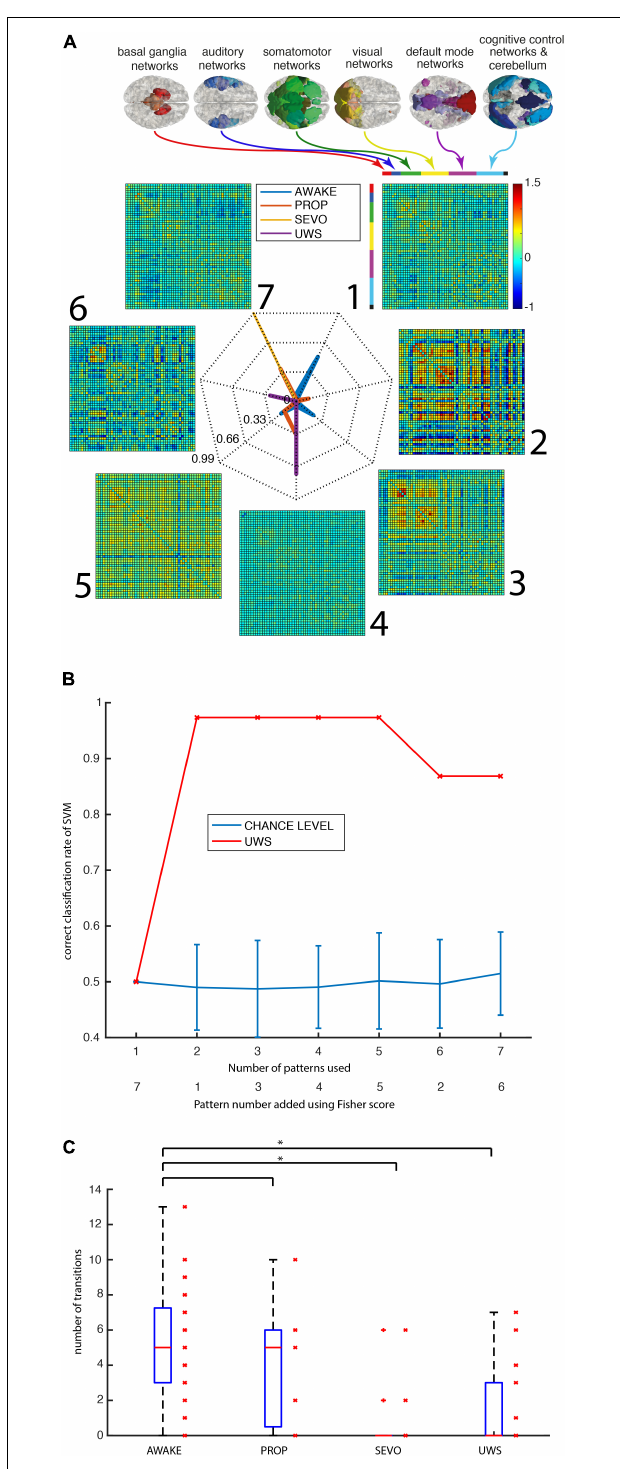
FIGURE 2 | Patterns are specific for intact consciousness. (A) Individual data points of the pattern matrices arise from different groups of functional networks: basal ganglia, auditory, somatomotor, visual, default mode, cognitive control, and cerebellar networks. The radar plot shows the patterns 1–7 and their relative distribution of appearance in the different groups